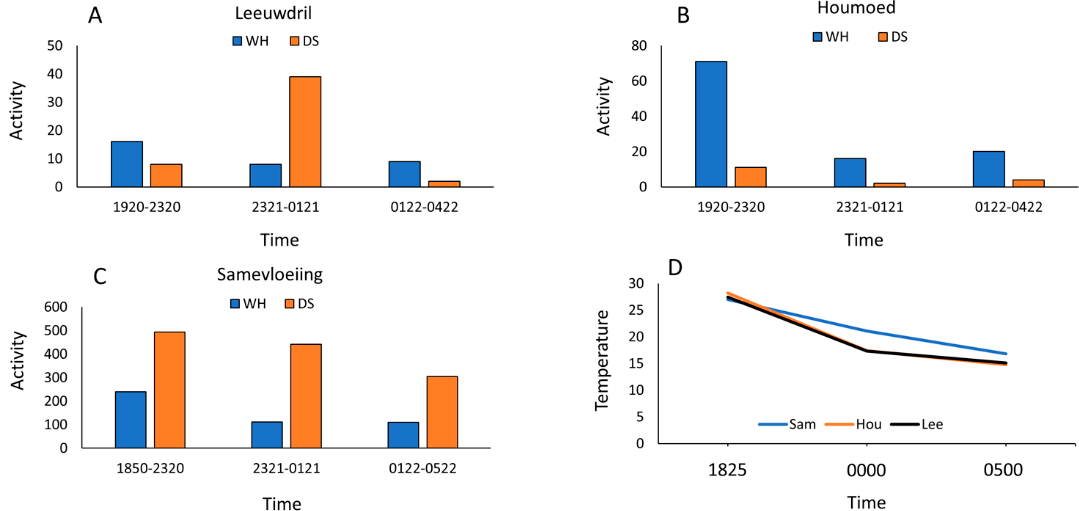
Figure 8. Distribution of activity between paired dry and wet sites sampled simultaneously. Wet sites indicate drinkable water source for bats. Dry = reference sites approximately 1 km from wet sites. Overall, Χ 2 analysis indicated significantly higher activity at dry sites. Open dots indicate mean temperature with standard deviations over the recording periods. Only Houmoed showed more activity at the water source than the reference dry site. Tukey-Kramer analysis on mean temperatures (gray dots with bars indicating standard deviations) indicated that the night Houmoed was sampled (mean = 23.1 °C, SD = 3.6) was significantly higher (DF = 430, CV = 3.15, P = 0.0001) than on the other sampling nights (Leeuwdril 19.8 °C, SD 3.9 and Samevloeiing 23.3 °C, SD = 3.1).